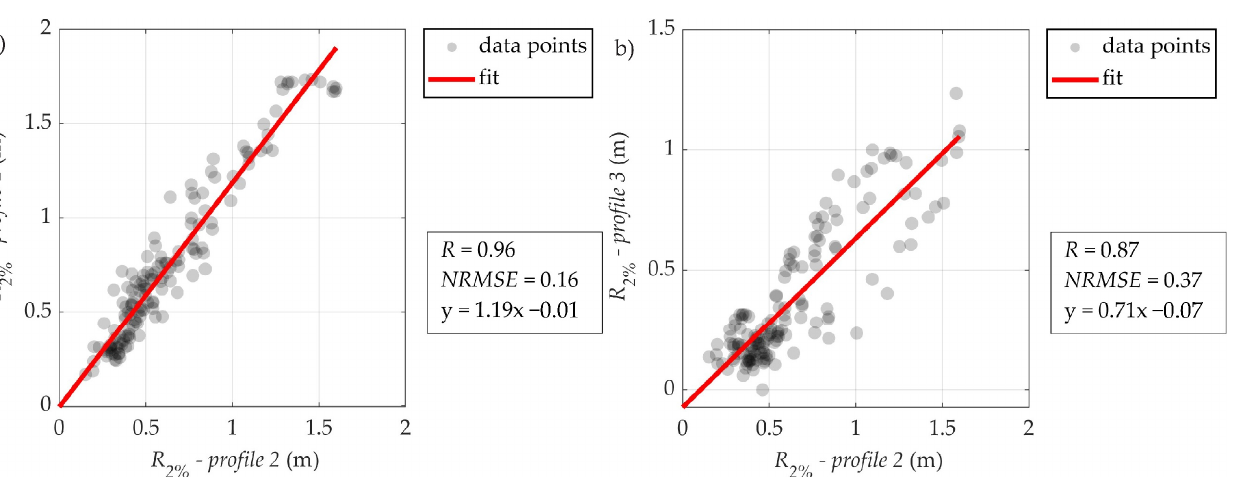
Figure 10. Comparison between the observed runup values on fetch-limited pocket beach Plo č e and those predicted using the modified P16a equation by including the Goda peakedness parameter, Qp (Equation (9)).